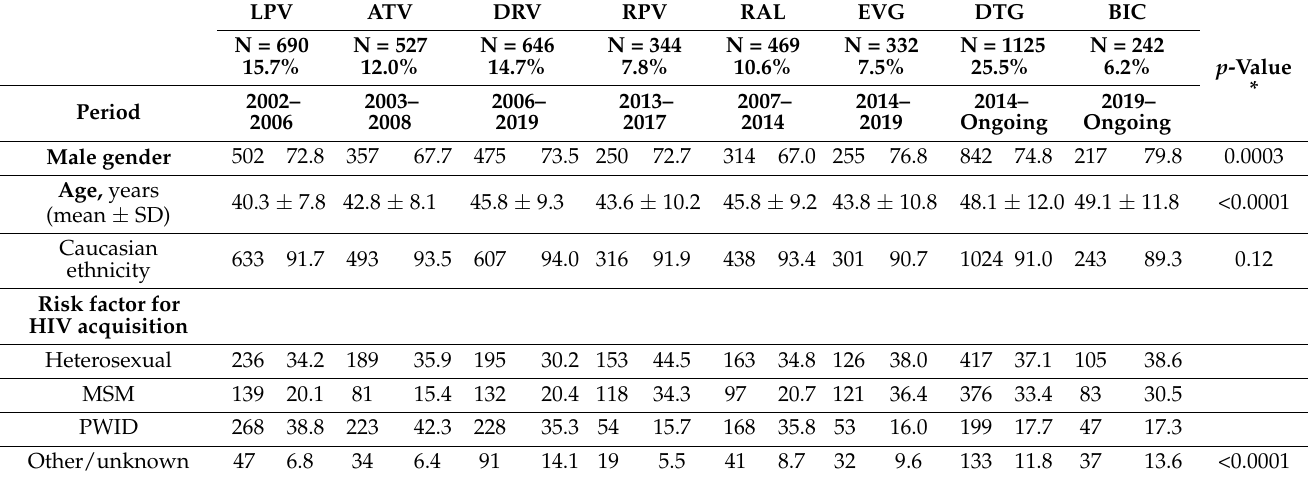
Table 1. Characteristics of 4405 people living with HIV, by SCOLTA